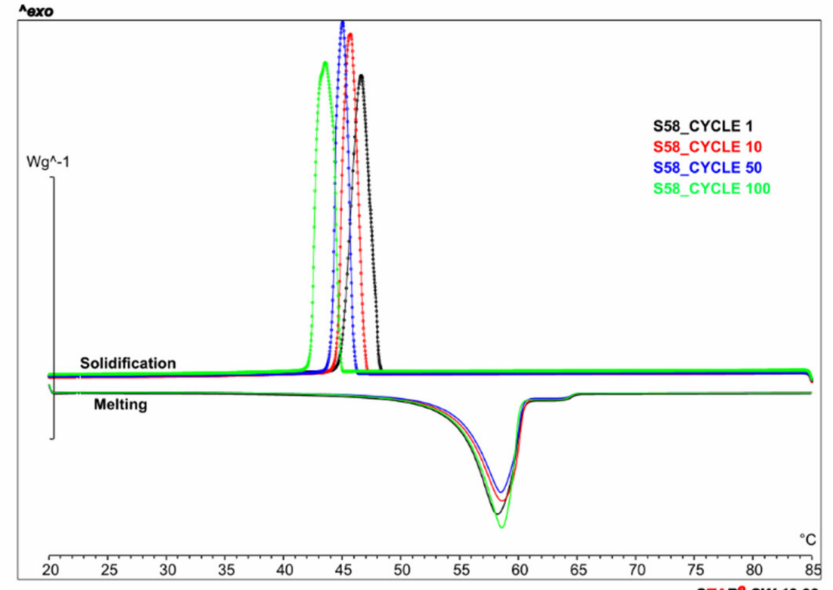
Figure 1. DSC curves evaluated for PCM S58 at 1, 10, 50, 100 cycles.